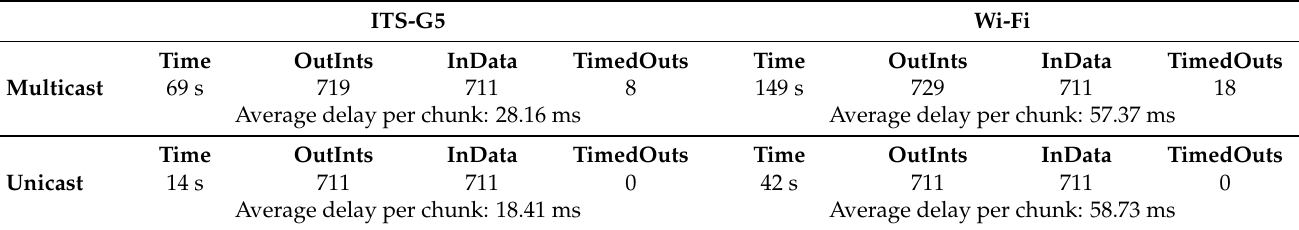
Table 3. Non-Pipelined results—full 6 MB file using both ITS-G5 and Wi-Fi (3 MB to each interface). ITS-G5 Wi-Fi